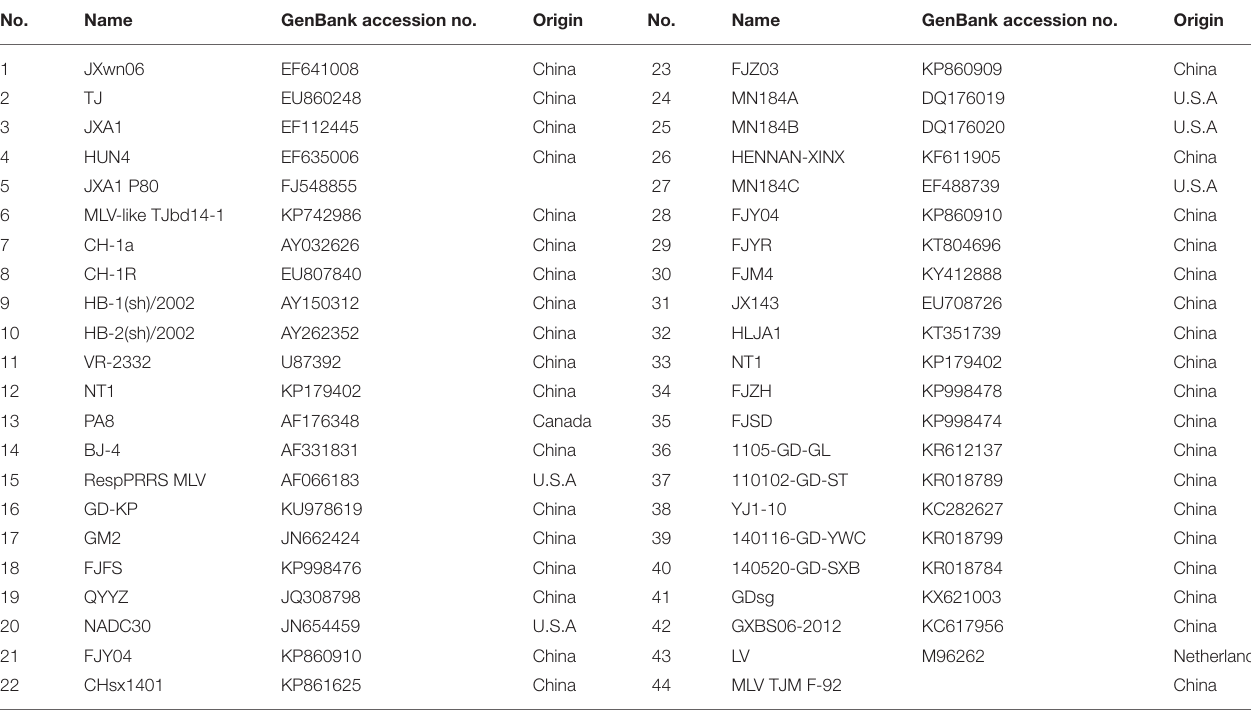
TABLE 1 | Representative PRRSV strains used in this study.